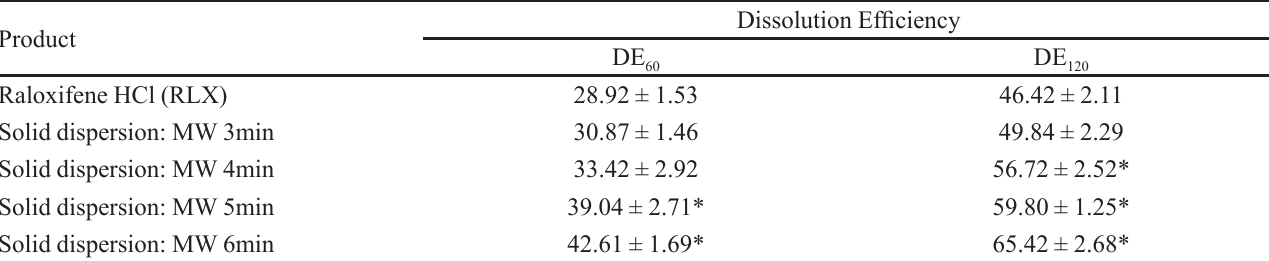
TABLE III - Dissolution efficiency of RLX and solid dispersions Product